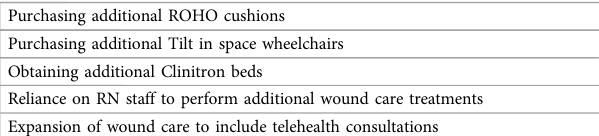
TABLE 5 Recommendations to meet increased needs for wound care among COVID-19 patients.